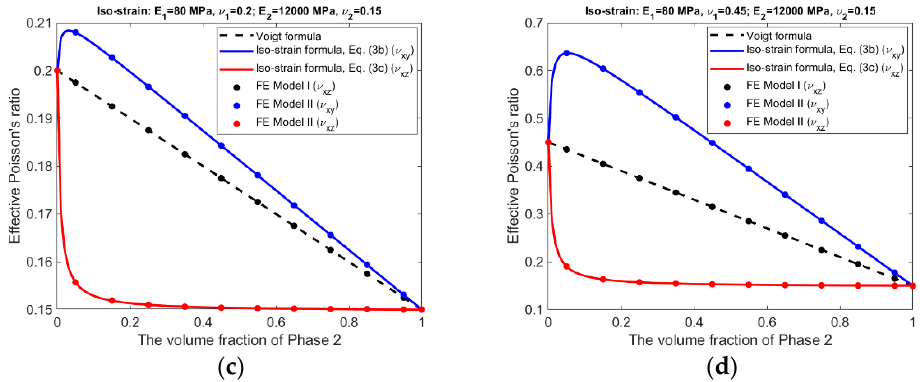
Figure 7. Iso-strain condition—Effective Poisson’s ratio predicted by analytical formulas and FEM. ( a ) Composite #1. ( b ) Composite #2. ( c ) Composite #3. ( d ) Composite #4. For the iso-stress condition, the corresponding results are presented in Figures 8 and 9.